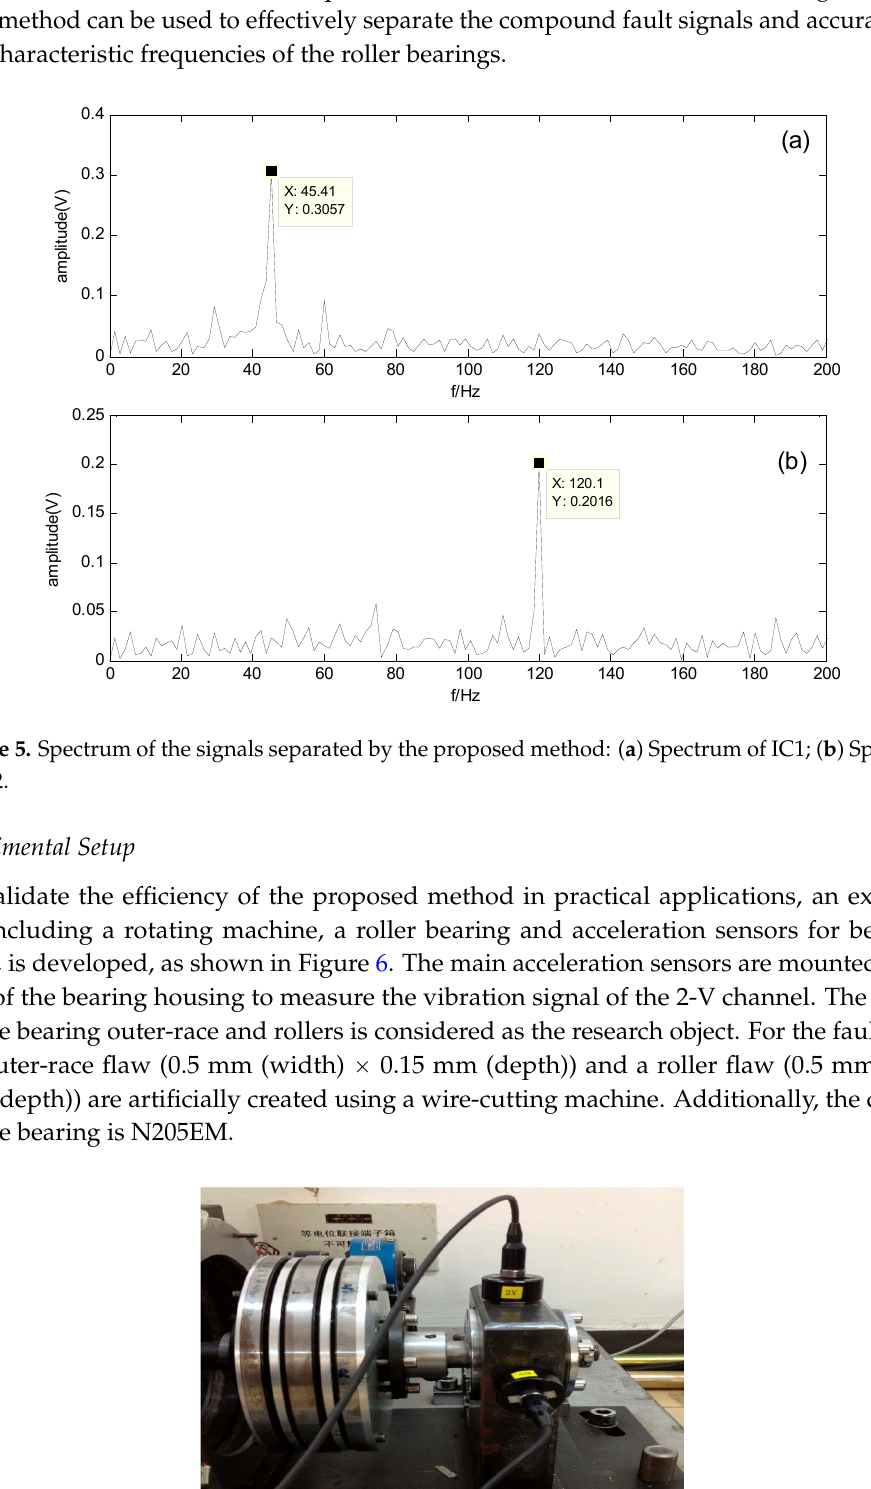
Figure 6. Experimental system and installation locations of the acceleration sensors.